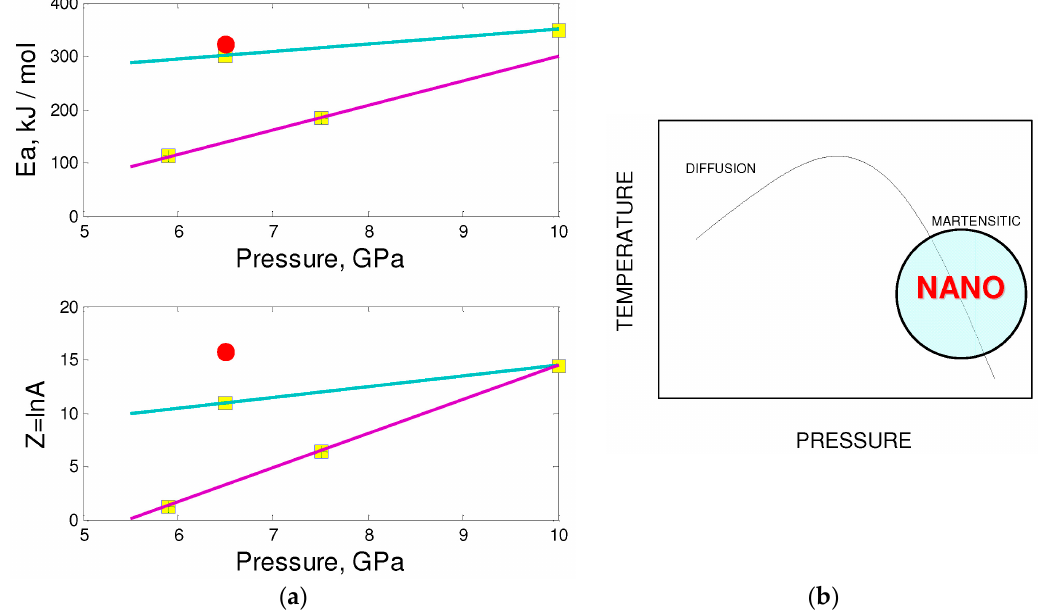
Figure 9. Kinetic parameters for hBN-to-cBN transformation: ( a ) Activation energy (top) and logarithm of pre-exponential factor (bottom) as function of pressure (open squares for pyrolytic hBN, crossed squares for hBN of technical grade, open circles for pure hBN obtained by thermally induced ordering of tBN); ( b ) Pressure–temperature diagram indicating the relative position of diffusive and displacive (martensitic) mechanisms. The latter favor the formation of nanostructures.